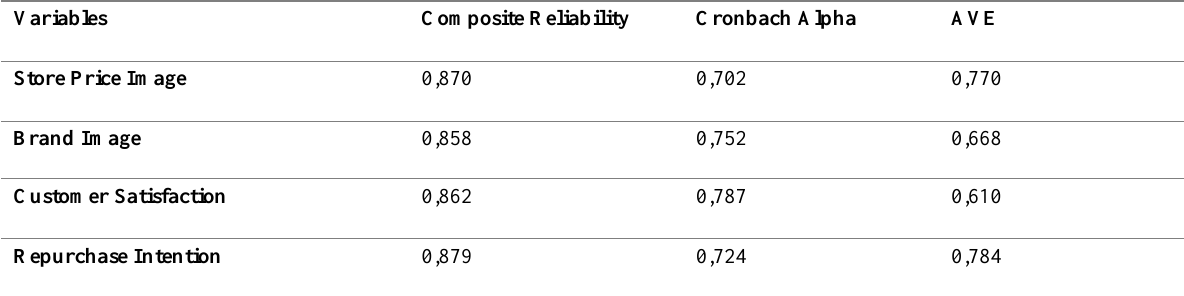
Table 1: Composite Reliability, Cronbach Alpha,